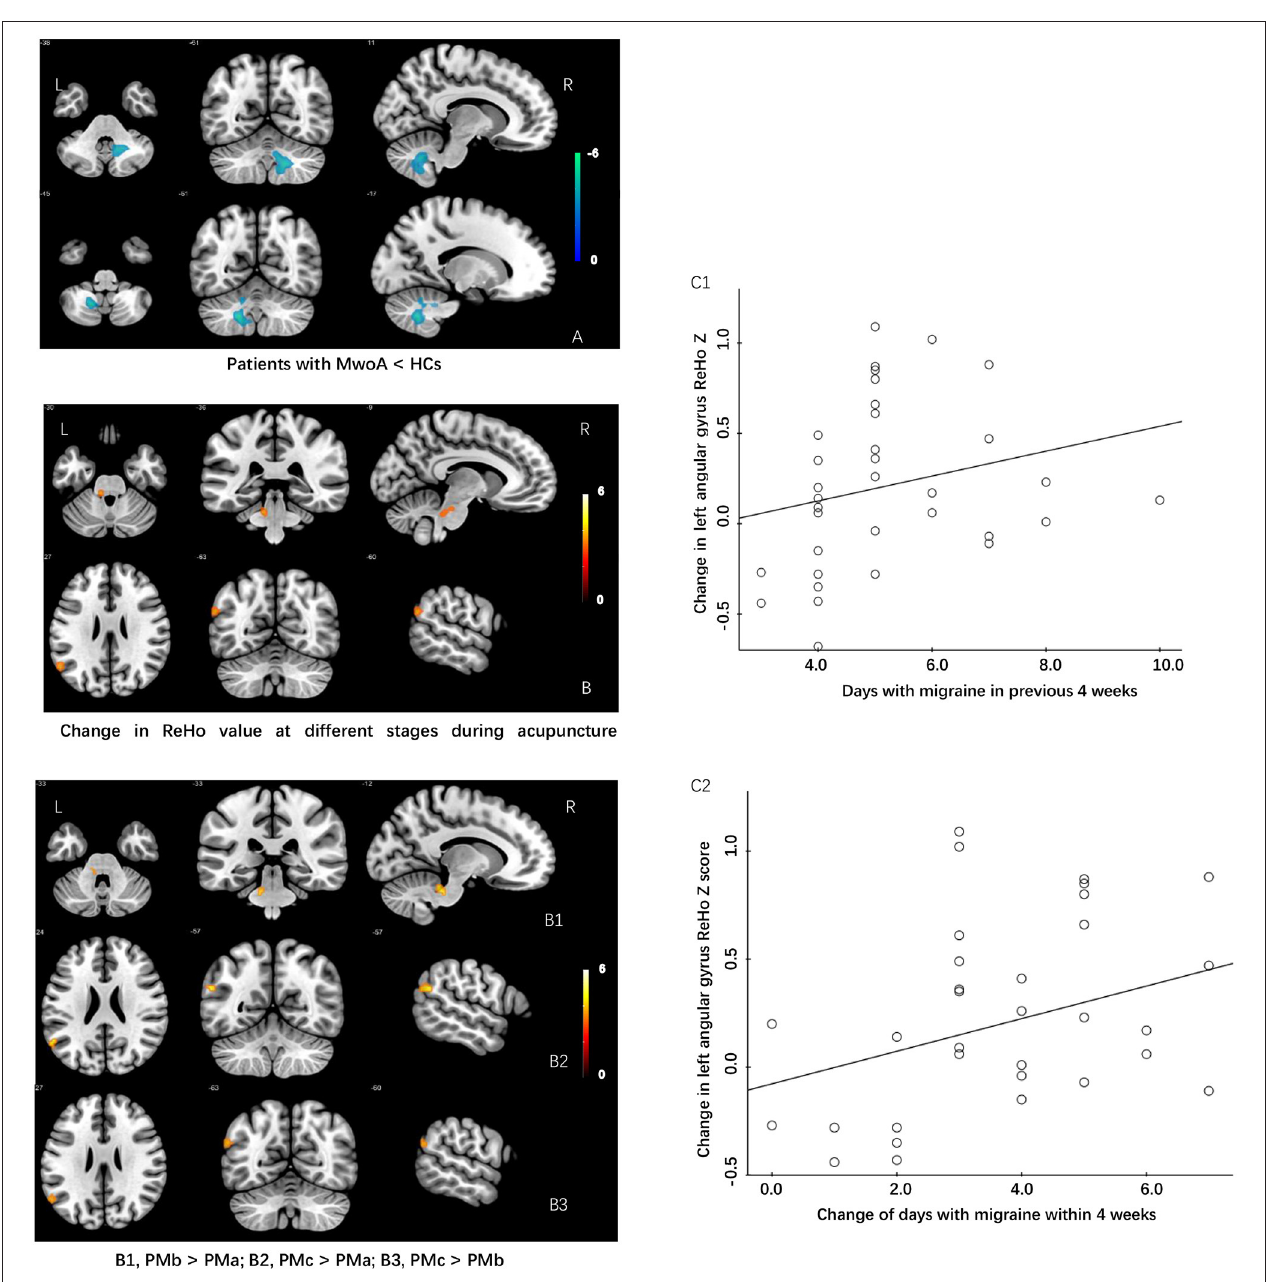
FIGURE 2 | Differences in ReHo values and modulating effects of acupuncture at different periods during treatment between patients with MWoA and HCs. (A) ReHo value is lower in patients with MwoA than in HCs. (B) Increase in ReHo value during different periods of acupuncture treatment in patients with MwoA. (B1) Increase in ReHo value in the left cerebellum after the first acupuncture treatment compared with baseline. (B2) Increase in ReHo value in the left angular gyrus after the 12th acupuncture treatment compared with baseline. (B3) Increase in ReHo value in the left angular gyrus after the 12th acupuncture treatment compared with the first acupuncture treatment. (C1) The change in the ReHo value in the left angular gyrus was positively correlated with the number of days with migraine in the past 4 weeks at baseline. (C2) Change in the ReHo value in the left angular gyrus was positively correlated with a change in the number of days with migraine within the past 4 weeks. HCs, healthy controls; ReHo, regional homogeneity; MWoA, migraine without